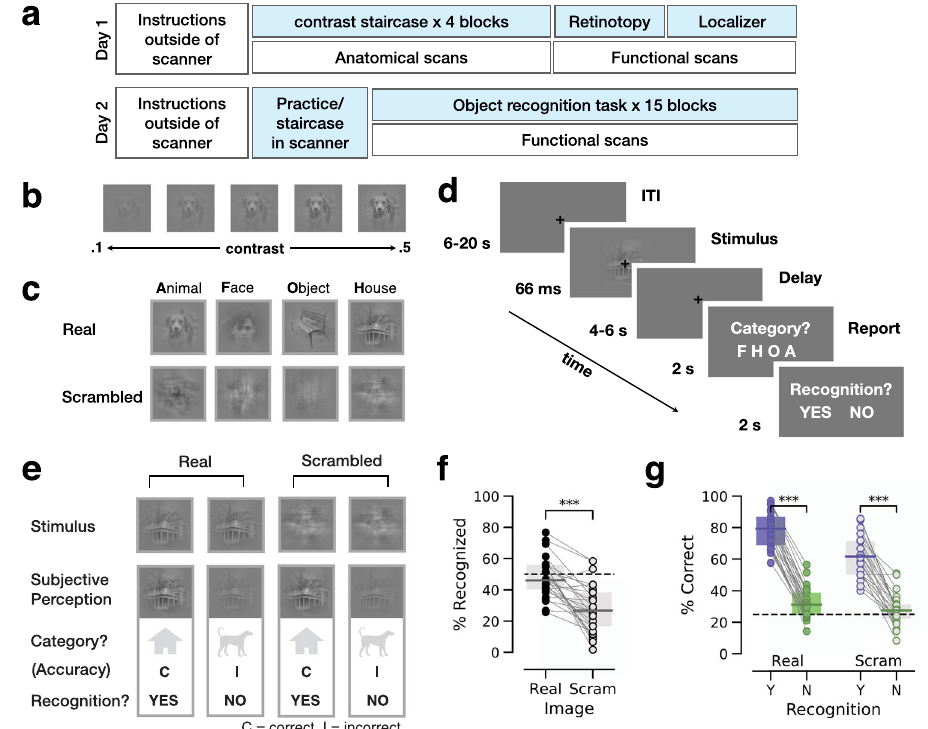
Fig. 1 Experimental paradigm and behavior. a A schematic timeline of experimental sessions conducted across two days. b Example of an object image presented at various levels of contrast. c Examples of real and scrambled object images from four categories. d Trial structure of the main object recognition task. Following a central fi xation period, participants viewed a brief stimulus presented at an individually-calibrated recognition threshold contrast. Next, participants reported the stimulus category and their recognition experience. e Illustration of trial types. Each participant may report the same stimulus (top) as recognized in one trial and as not recognized in another. f Percentage of trials reported as recognized for real and scrambled images ( N = 25). Dashed line indicates intended threshold-level recognition rate for real images (two-sided Wilcoxon sign-rank test). *** p = 4.1 × 10 − 5 . g Accuracy of category report in recognized and unrecognized image trials for real ( N = 25, *** p = 1.2×10 − 5 ) and scrambled ( N = 22, only subjects reporting more than 5 scrambled-image trials as recognized are included, *** p = 5.96 × 10 − 5 ) images (two-sided Wilcoxon sign-rank test). The accuracy of reported category in scrambled-image trials is determined based on the category of the original stimulus used to generate the scrambled image. In all fi gures, boxplot center line depicts the median and bounds indicate upper and lower